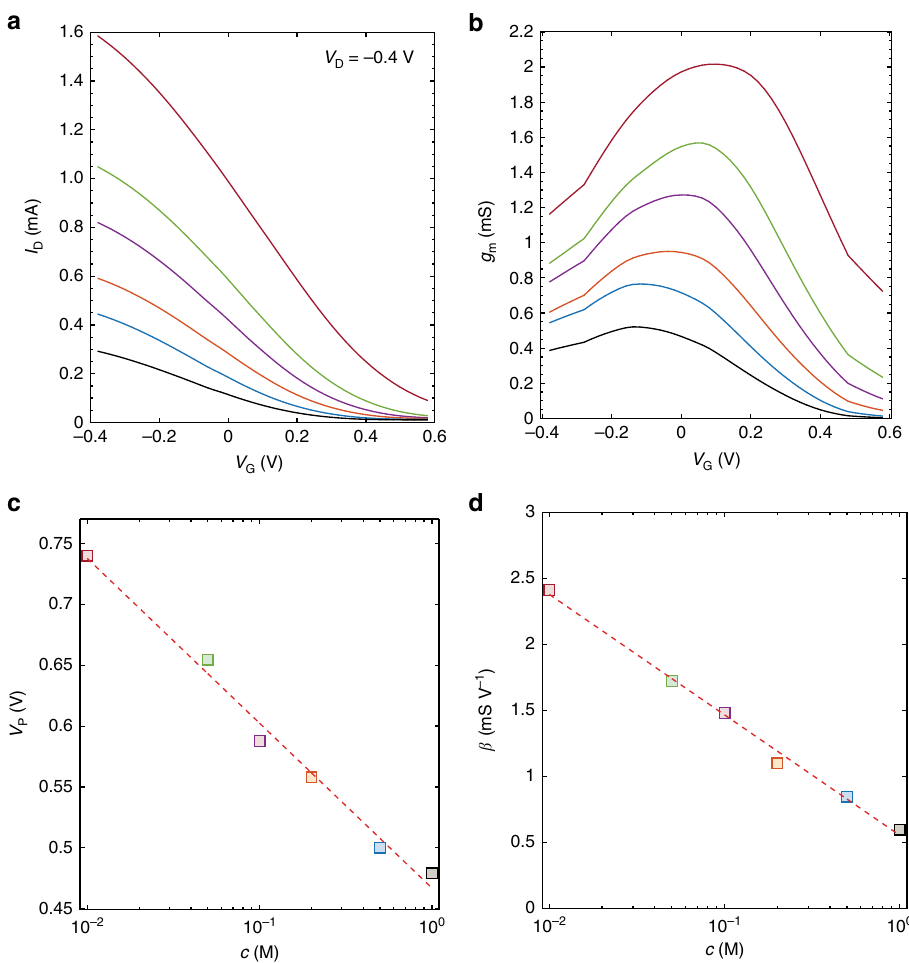
Fig. 4 OECT characteristics and parameters as a function of the ion concentration. a Measured transfer characteristics of an OECT at several NaCl concentrations c , V D = 0.4 V and b corresponding transconductance ( g m ). c Pinch-off voltage V P as a function of the ion concentration. V P is extracted by 29,39 : I fi tting the I − V = 2 β ( − V + V + V D G with the model D G P D /2) V D . The crossing point (named V X ) between the linear least square approximation of I D and the V G -axis provides V P = V X − V D /2. The average sensitivity is Δ V P / Δ c = − 135 mV dec − 1 . d Current prefactor β as a function of the ion concentration. The average sensitivity is Δ β / Δ c = − 0.9 mS V − 1 dec − 1 . The gate is a tungsten foil and the OECTs geometries are: W = 1000 µ m, L = 300 µ m, t = 25